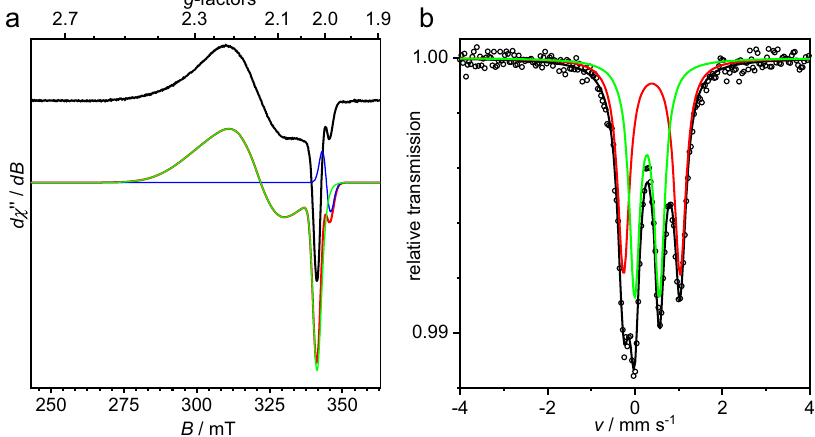
Fig. 5 Spectroscopic characterization of the oxidized complex [(susan 6-Me ){Fe IV ( μ -O)( μ -O 2 )Fe III }] 3 + . a X-band EPR spectrum of chemically oxidized [(susan 6-Me ){Fe IV ( μ -O)( μ -O 2 )Fe III }] 3 + in ≈ 0.4 mM CH 3 CN solution at 10 K (top, 9.63312 GHz, 80 μ W power, 0.75 mT modulation) and its simulation (bottom; simulation red trace, green and blue traces subspectra) with the parameters provided in the text. b 57 Fe Mössbauer spectra of 57 Fe-enriched, chemically oxidized [(susan 6-Me ){Fe IV ( μ -O)( μ -O 2 )Fe III }] 3 + in frozen CH 3 CN solution at 180 K. The solid lines are simulations with parameters provided